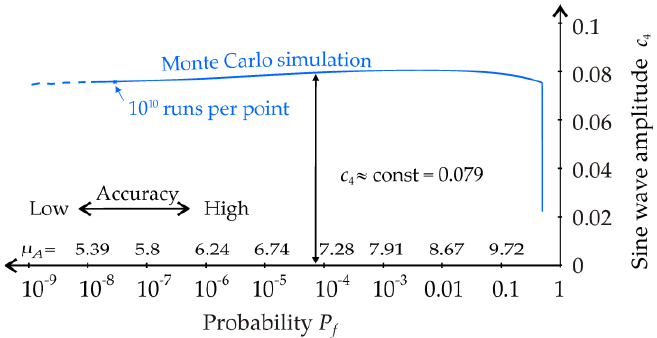
Figure 13. Parameter of pseudorandom model uncertainty — case study 7.